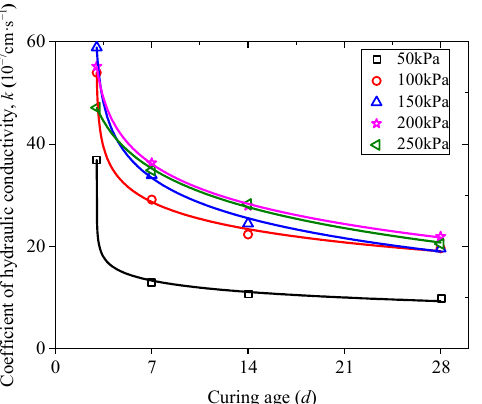
Figure 17. Relationship between hydraulic conductivity coefficient and curing age at different osmotic pressures ( D R = 42%). Table 8. Values of A , B , C for hydraulic conductivity coefficient expression.